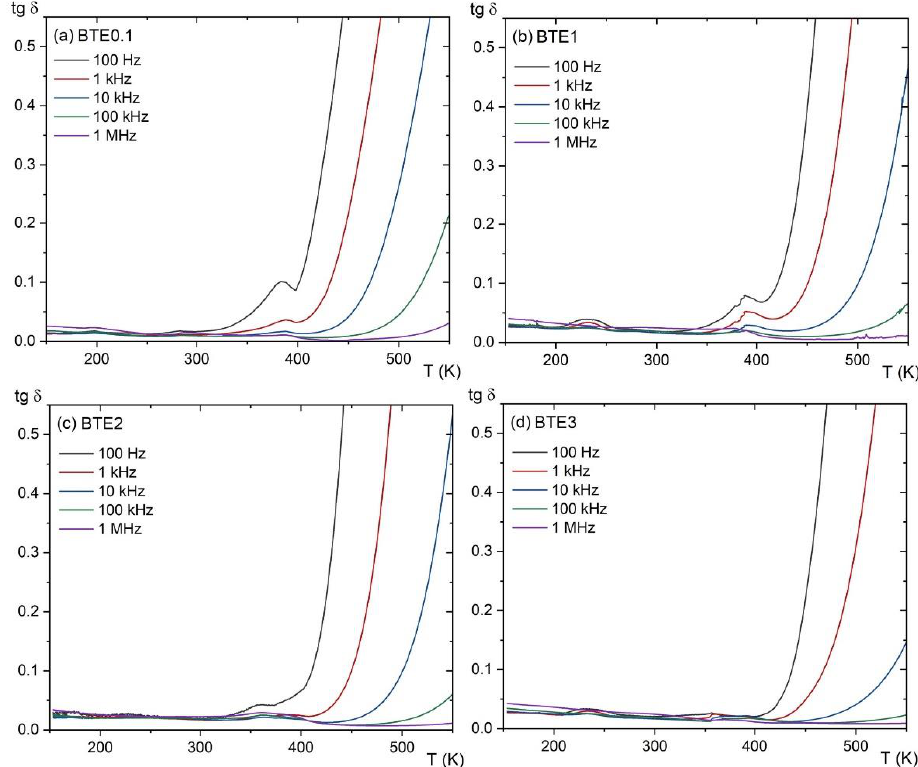
Figure 6. The evolution of the dielectric losses as a function of temperature at different frequencies for BTEx ceramics: ( a ) BET0.1, ( b ) BTE1, ( c ) BTE2, and ( d ) BTE3. for BTEx ceramics: ( a ) BET0.1, ( b ) BTE1, ( c ) BTE2, and ( d )